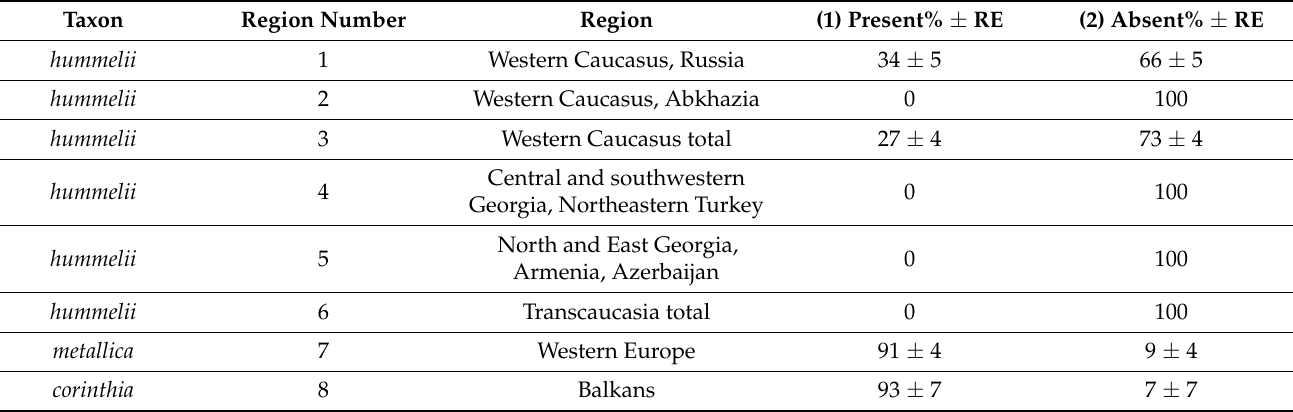
Table 12. Border at upper margin of elytral epipleura near base. RE—share representativeness error. Taxon Region